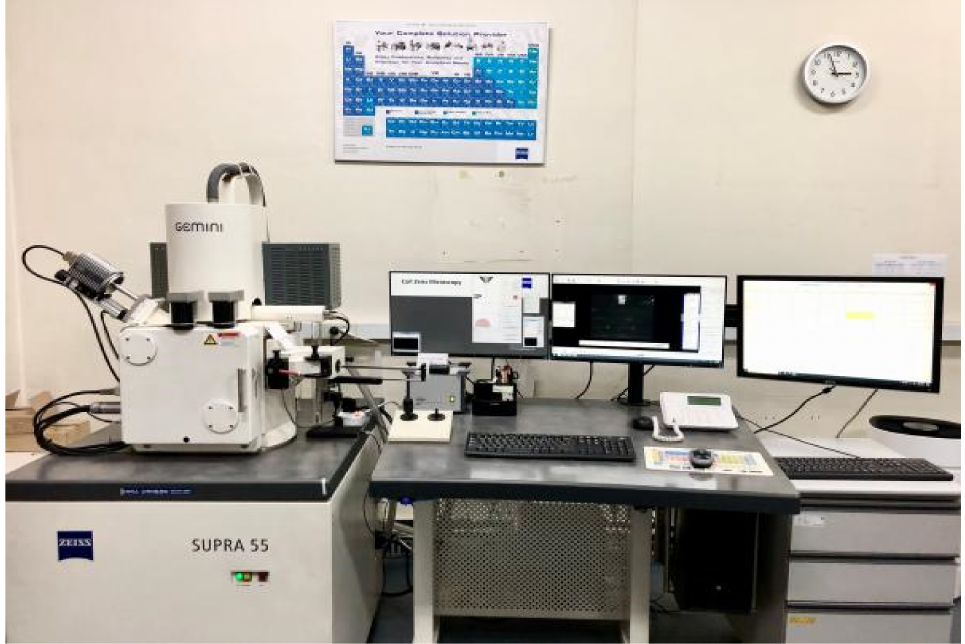
Figure 4. Scanning Electron Microscope, Model: LEO SUPRA